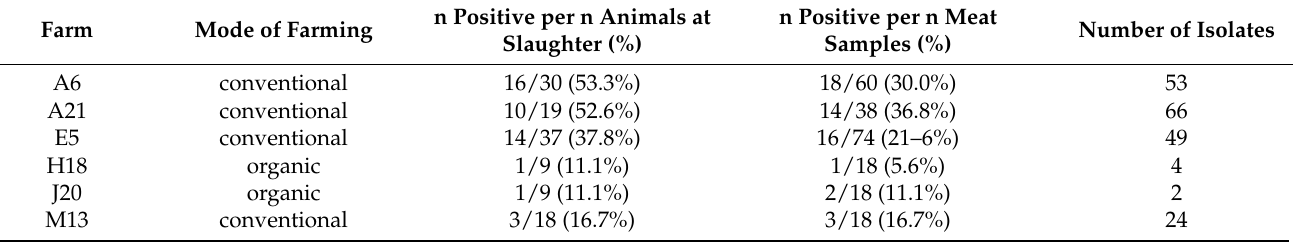
Table 9. Occurrence of E. coli on meat, farmwise